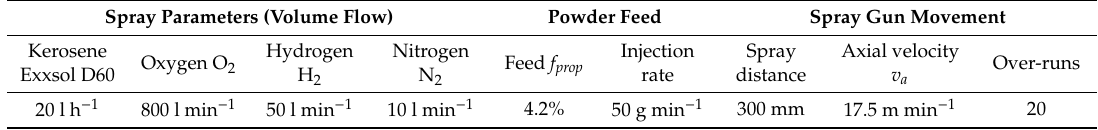
Table 3. Spray parameters of WC–12Co sprayed Table 2. Process parameters and tool specifications on the microfinishing steps.